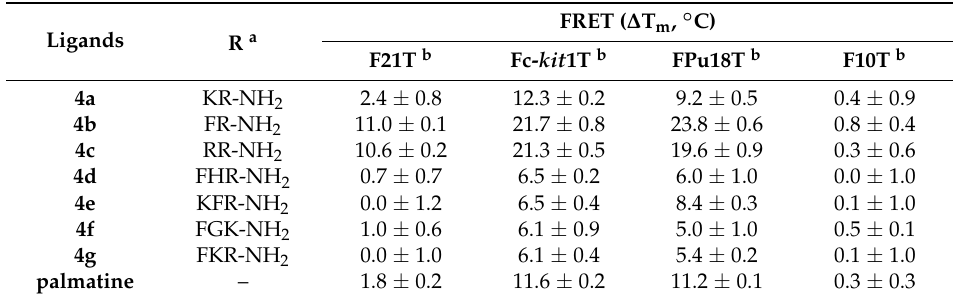
Table 4. G-quadruplex DNA and duplex DNA stabilization temperatures ( Δ T m ) obtained from FRET melting assay.